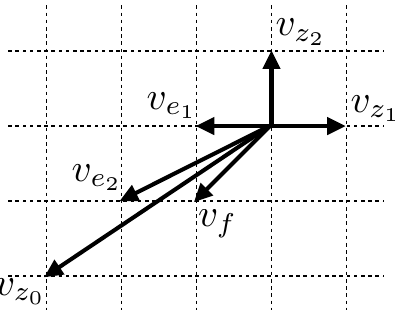
. To each ray is associated a homoge- 132